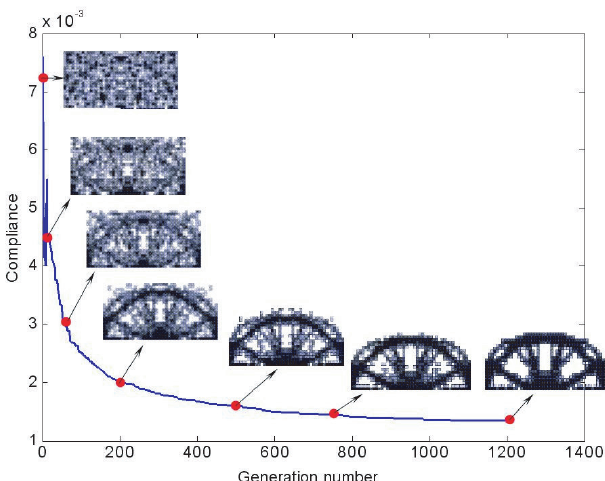
Fig. 9. Best solution and its objective value